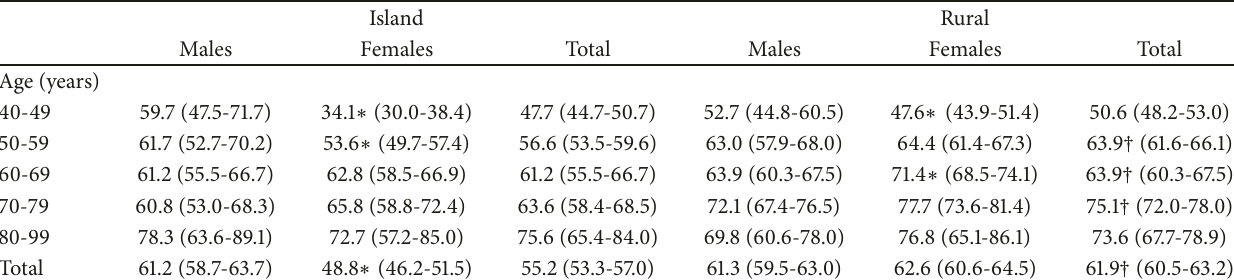
Table 3: Weighted prevalence of hypertension stratified by age and sex [% (95% CI)]. Island Rural Males Females Total Males